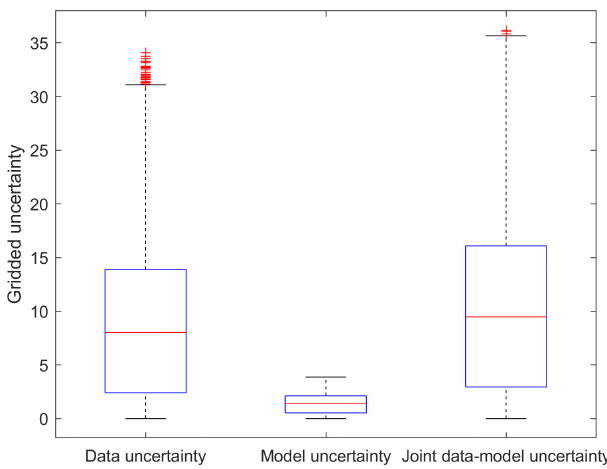
Figure 10. The distributions of the predictive uncertainty from data, model and joint data–model modeling methods for precipitation